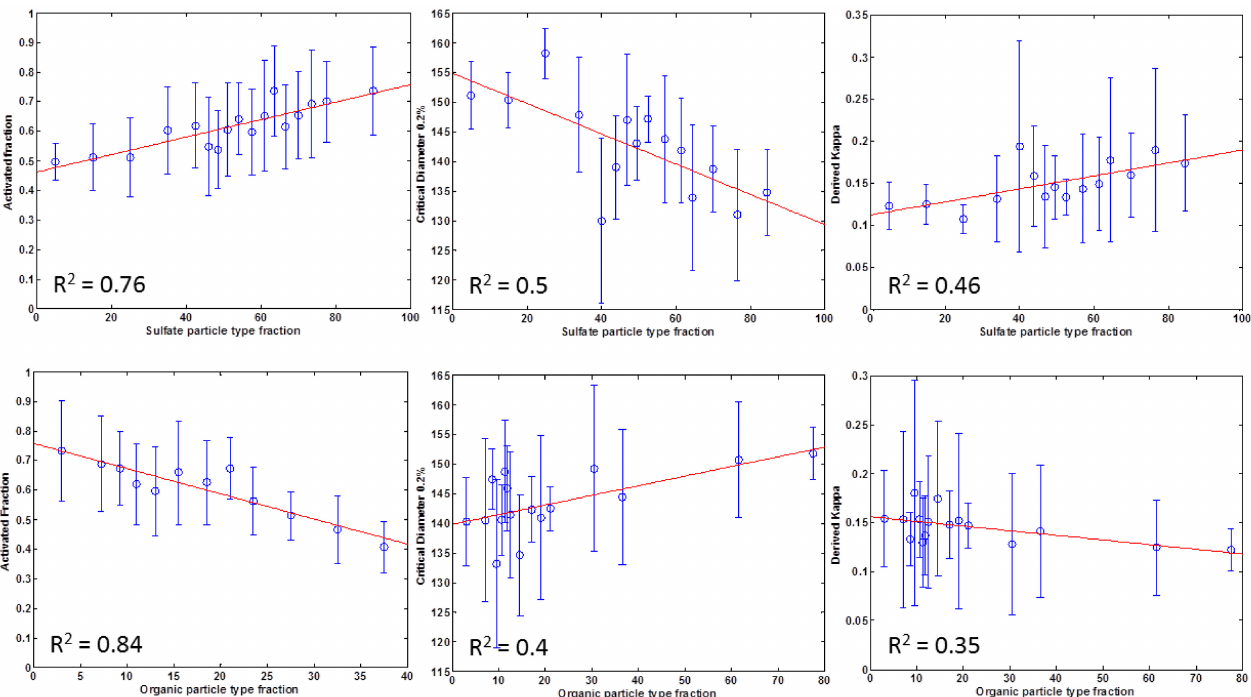
Fig. 8. Correlations between the fraction of sulfate-type particles (top panels) and organic-type particles (lower panels), as determined by SPLAT II, with the activated fraction of CCN (left panels), calculated critical diameter at 0.2% supersaturation (middle panels), and derived kappa parameter (right